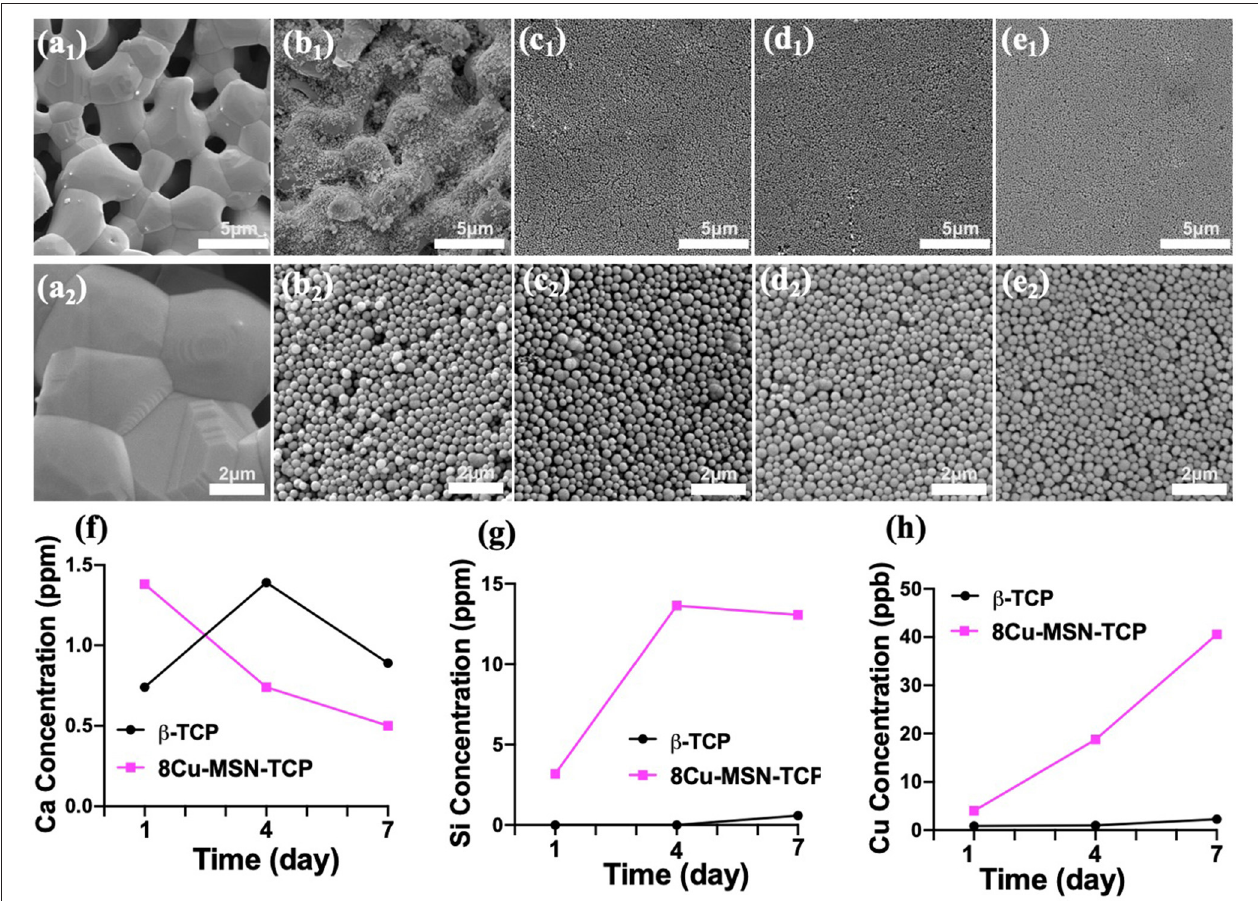
FIGURE 3 | Scanning electron microscope images of β -tricalcium phosphate ( β -TCP) (a 1 ,a 2 ) , 2Cu-MSN-TCP (b 1 ,b 2 ) , 4Cu-MSN-TCP (c 1 ,c 2 ) , 6Cu-MSN-TCP (d 1 ,d 2 ) , and 8Cu-MSN-TCP (e 1 ,e 2 ) scaffolds. The concentration of released Ca (f) , Si (g) , and Cu (h) ions from β -TCP and 8Cu-MSN-TCP scaffolds in phosphate-buffered saline (PBS) on days 1, 4, and